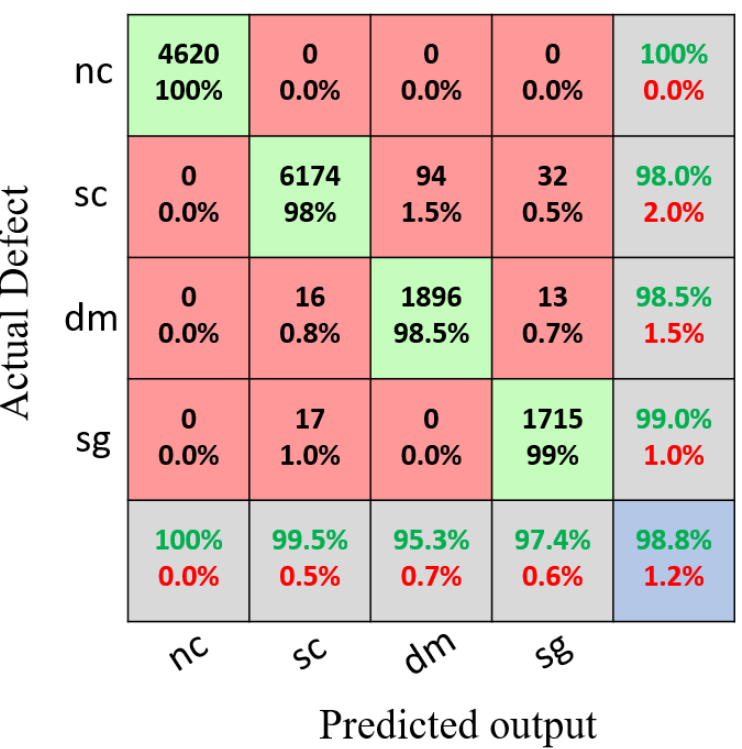
Figure 13. Results of the confusion matrix for the multivariant defects and non-crack concrete using the training set.